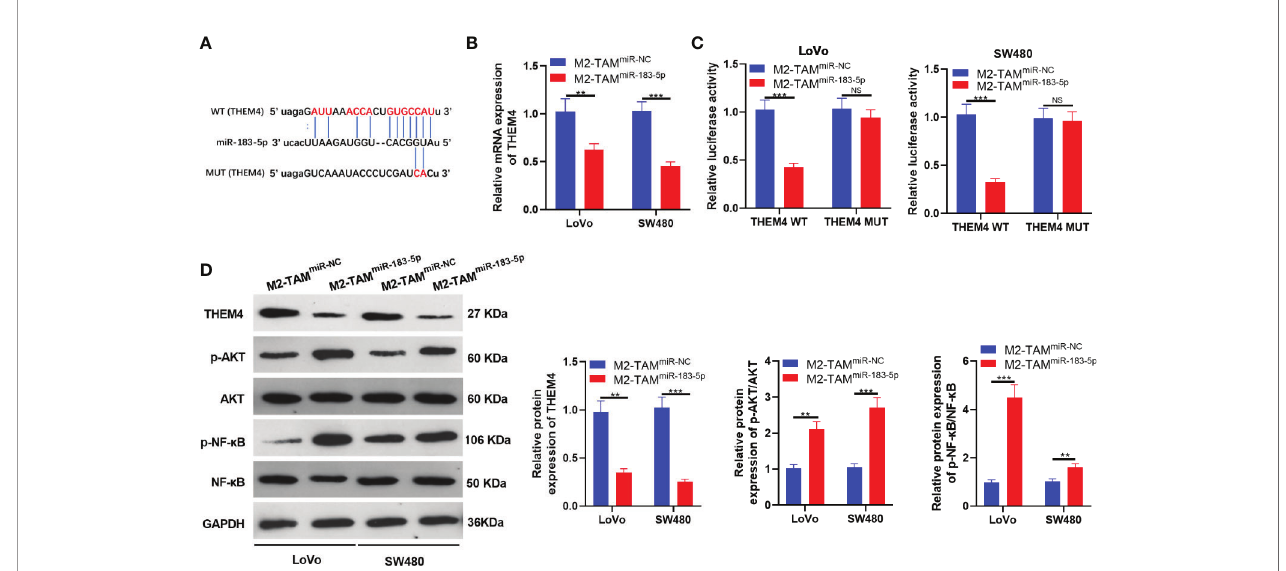
FIGURE 5 | miR-183-5p targeted THEM4. (A) Bioinformatics predicted the potential binding sites between miR-183-5p and THEM4. (B) The THEM4 level in LoVo and SW480 cells was monitored by qRT-PCR. (C) The targeting association between miR-183-5p and THEM4 was determined by the dual-luciferase reporter assay in SW480 and LoVo. (D) The expression of THEM4, Akt and NF- k B was compared by WB. ns, P >0.05, ** P < 0.01, *** P < 0.001 ( vs . The M2-TAM miR-NC group). N=3.